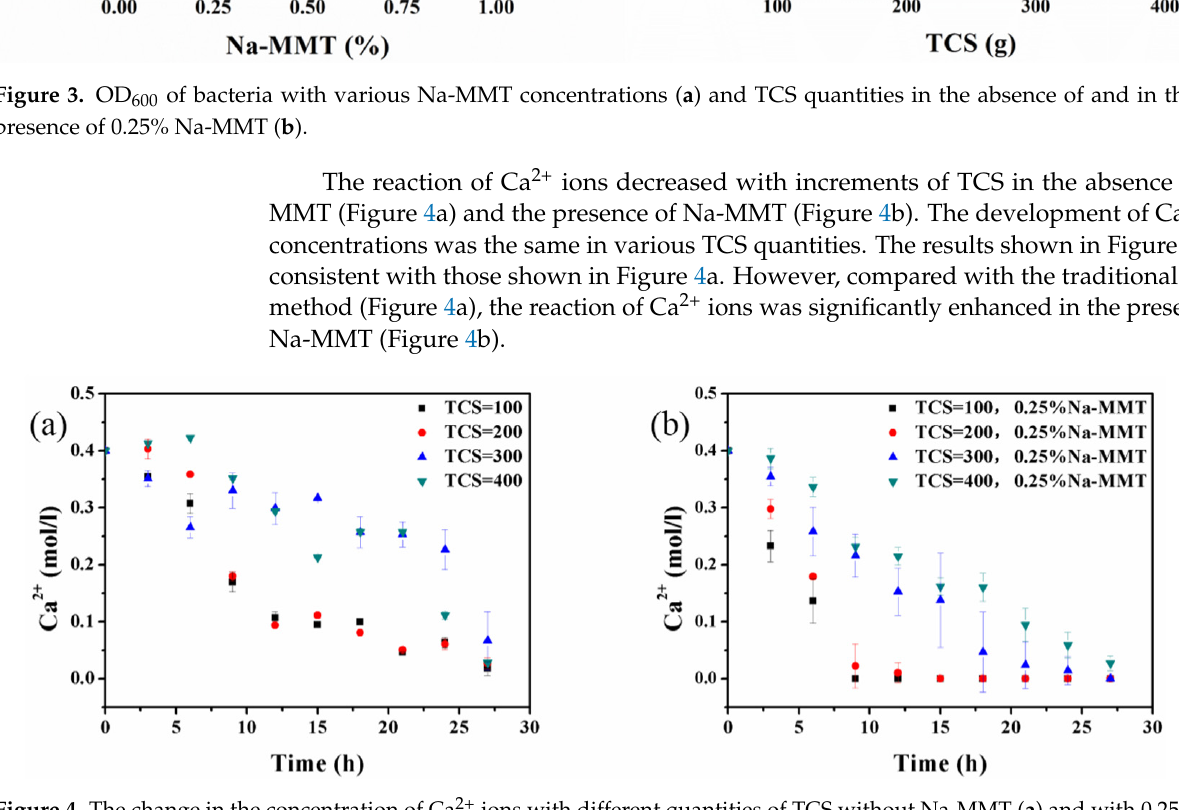
Figure 4. The change in the concentration of Ca 2+ ions with different quantities of TCS without Na-MMT ( a ) and with 0.25% Na-MMT ( b ).